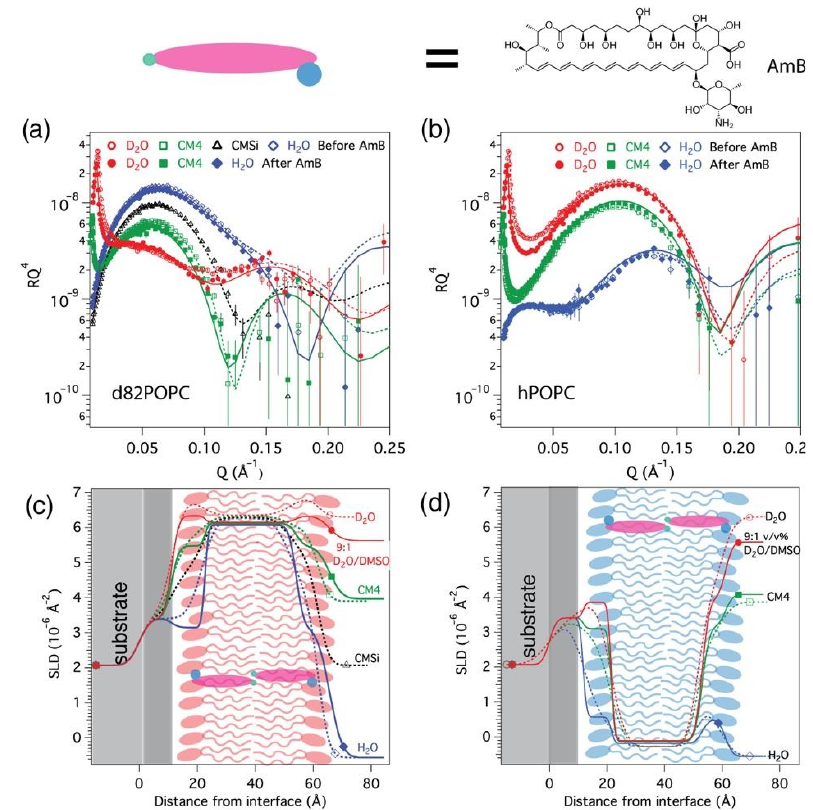
Figure 1. Neutron reflectivity data and the corresponding neutron scattering length density profiles of d 82 POPC (1-palmitoyl-2-oleoyl- sn -glycero-3-phosphocholine) ( a , c ) and hPOPC ( b , d ) bilayers measured in di ff erent solvent contrasts at 30 ◦ C before (open symbols / dotted lines) and after (solid symbols / lines) addition of 1 mM amphotericin B (AmB). A schematic illustration of the membrane structure and location of AmB corresponding to the fits is presented over the scattering length densities (SLD) profile ( c , d ). Table 2. Parameters corresponding to the best fit to the data from d 82 POPC and hPOPC membranes before and after the addition of AmB addition, as displayed in Figure 1.